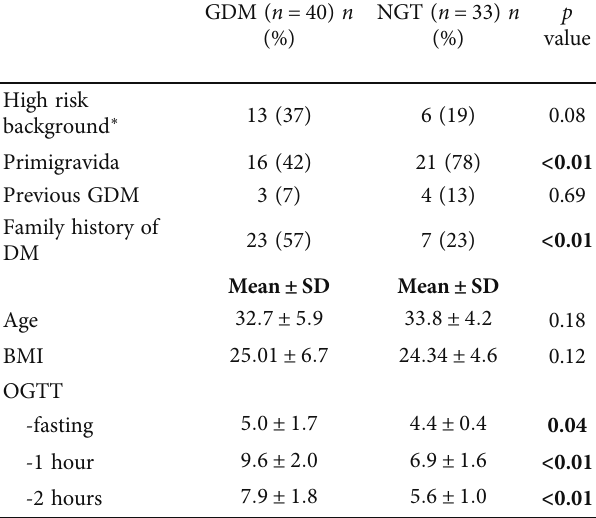
Table 2: Demographic statistics of participants.